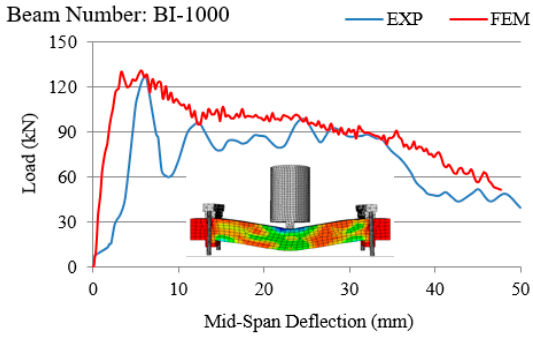
Figure 10. Load vs. mid-span deflection for BI-1000.